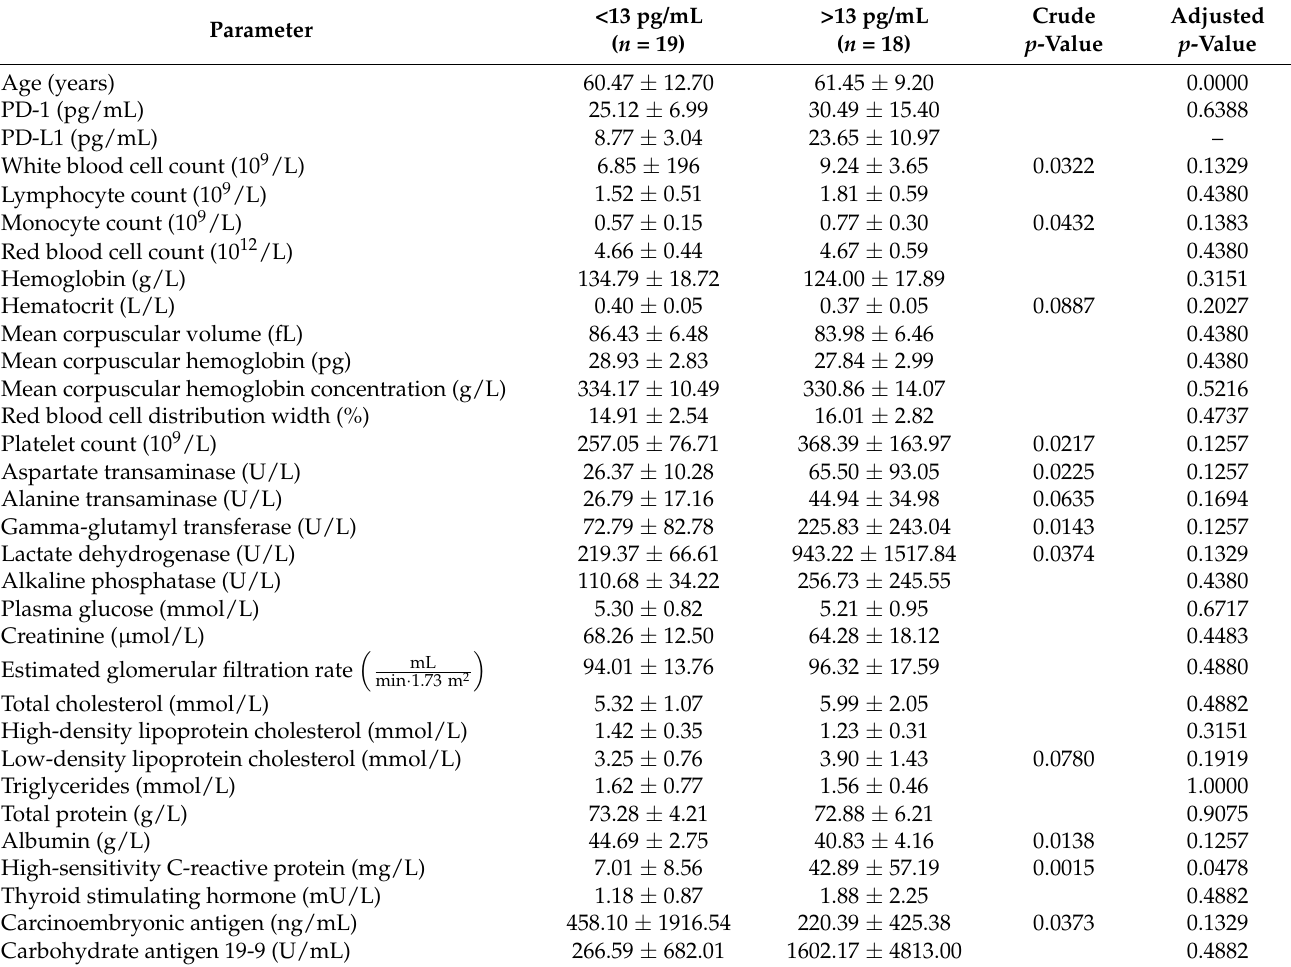
Table 4. Comparison of age and laboratory measurements of study participants with plasma PD-L1 levels under or over 13